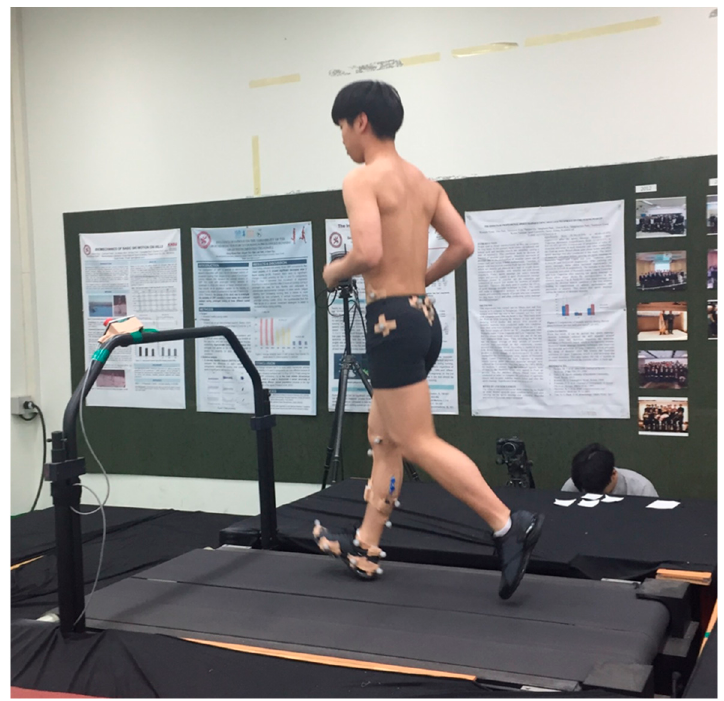
Figure 1. Experimental setting showing a participant running at 2.7 m/s on an instrumented treadmill.